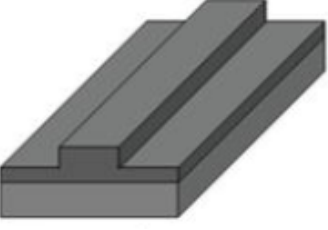
Fig. 1. Layout view of a ridge waveguide.